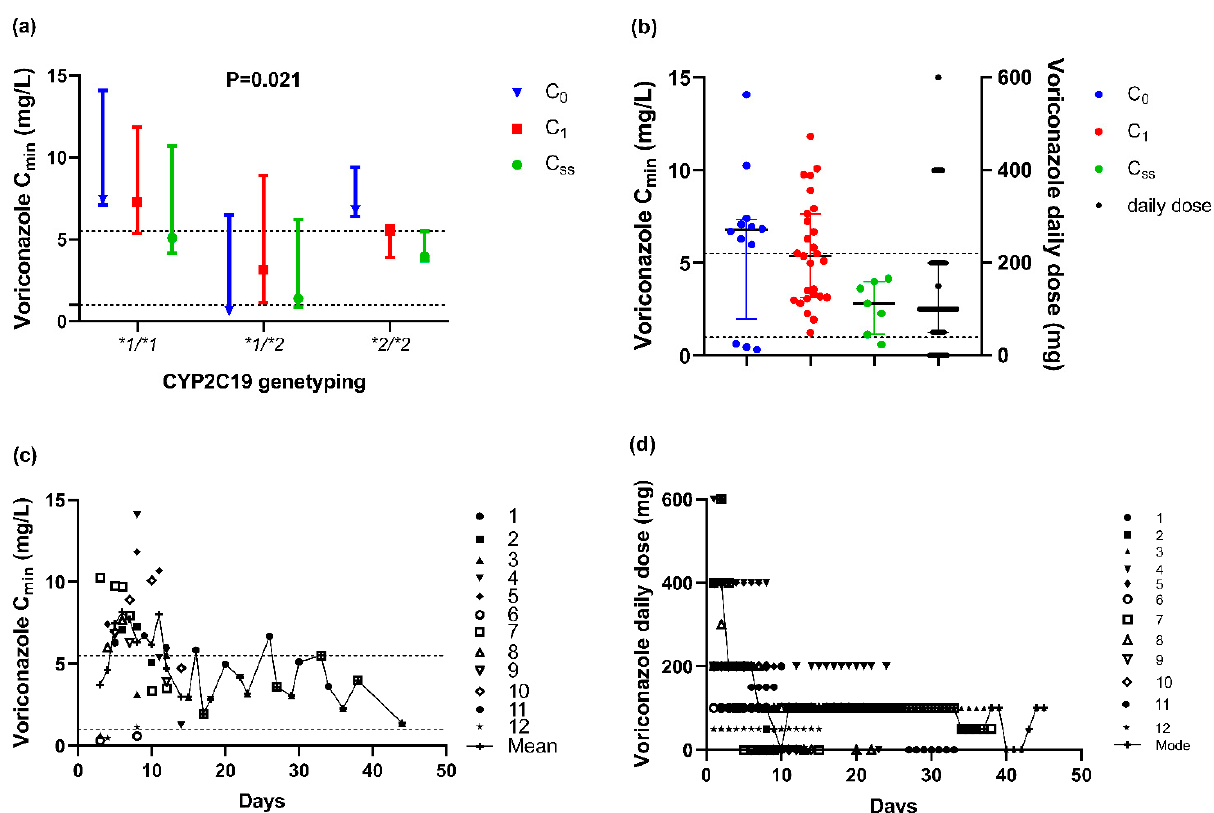
Figure 3. For 12 patients started beyond the therapeutic target ( a ) Distinction of voriconazole trough concentration in different CYP2C19 phenotype groups ( n = 50, p = 0.021). The Kruskal–Wallis test was used to compare C min s. ( b ) Distinction of voriconazole trough concentration in different groups of C 0 , C 1 , C ss ( n = 50), and daily dose ( n = 27). Data are expressed as the median ± interquartile range. ( c ) The mean concentration of such 12 patients changed by days. ( d ) Every dosage adjustment ( n = 247) and the mode dose ( n = 45) by days (It showed the highest one if there were more than one mode). *1, *2, *3, *17 reprented the single nucleotide sequence of genotype of CYP2C19 .